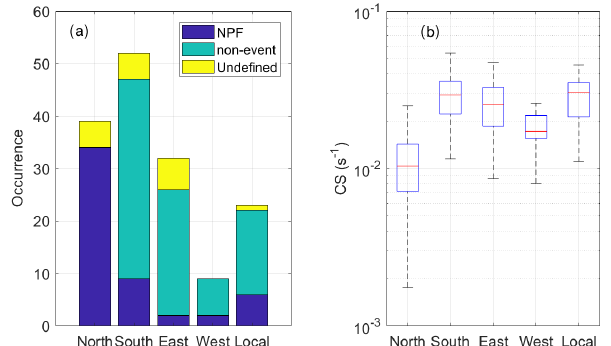
Figure 7. Occurrence of NPF events and non-events under air masses arriving from different directions (a) as well as medians and percentiles of condensation sink (CS, s − 1 ) during 09:00–11:00LT) under different air masses (b) during our observation in sum- mer 2018 and 2019 at the UB station. The red line represents the median of the data, and the lower and upper edges of the box repre- sent 25th and 75th percentiles of the data, respectively. The length of the whiskers represents 1.5 times the interquartile range, which includes 99.3% of the data. The time resolution of CS was